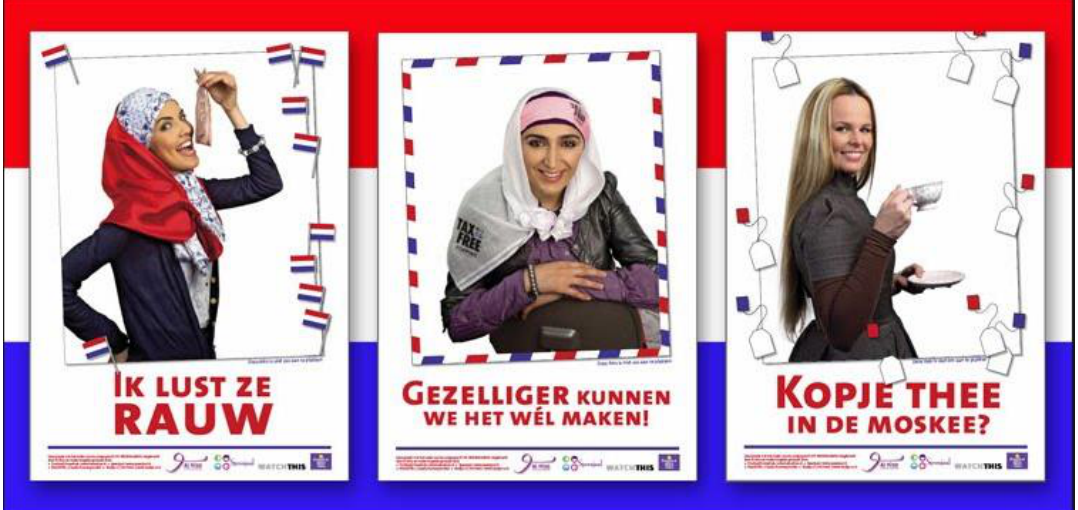
Figure A1. “Real Dutch?” Poster Campaign by Al Nisa. Societies 2018 , 8 , x FOR PEER REVIEW